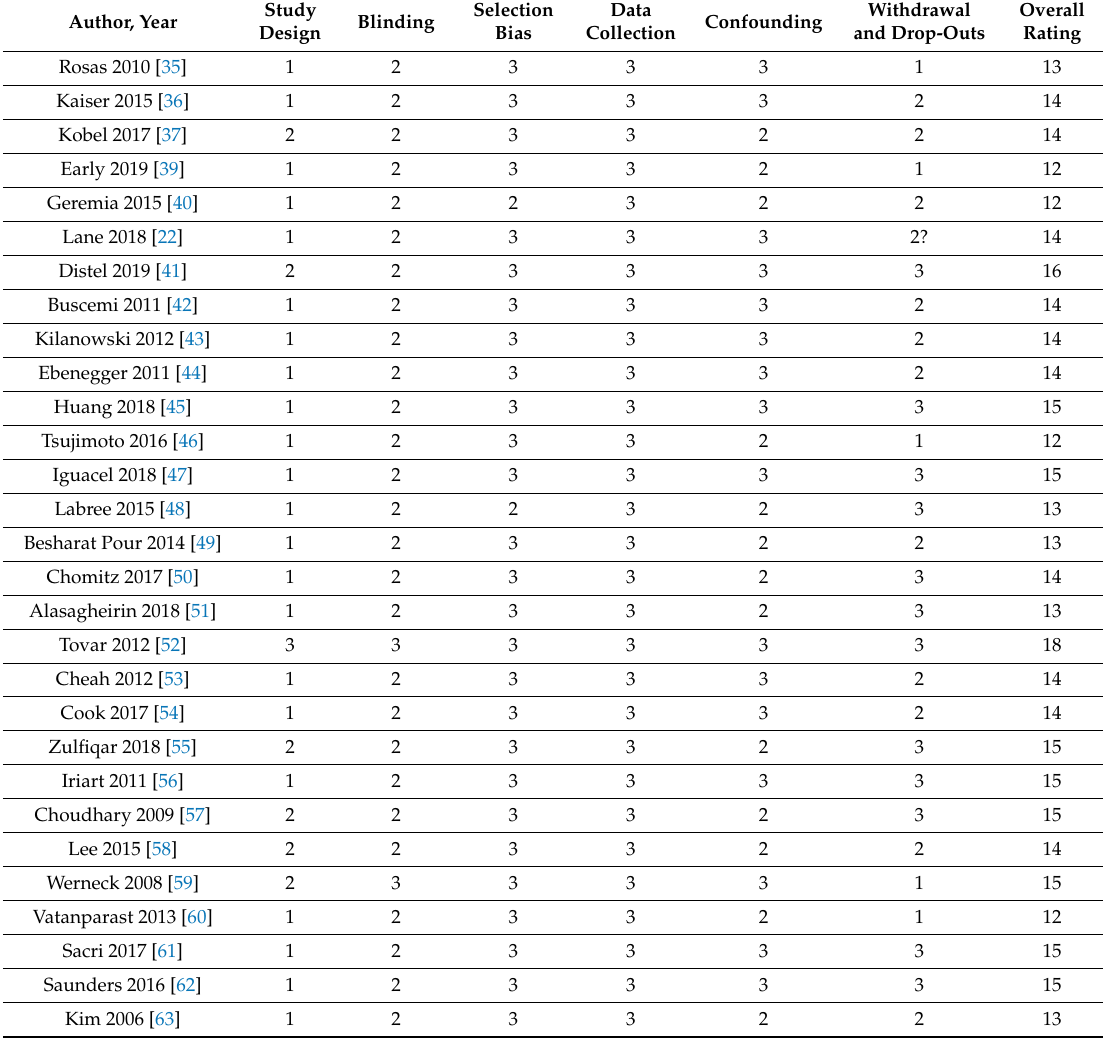
Table 8. Quality assessment of the included studies according to the EPHPP